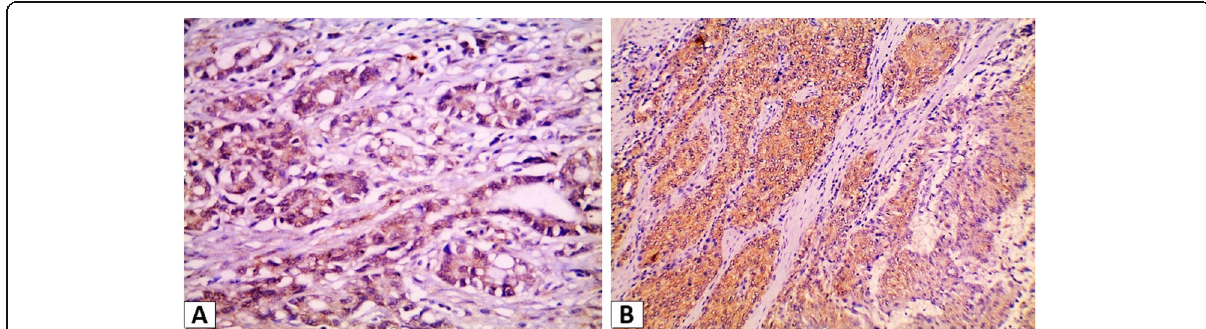
Fig. 5 VEGF expression in gastric carcinoma cases. Positive VEGF cytoplasmic expression in a moderately differentiated carcinoma (×400) and b poorly differentiated carcinoma (×200)